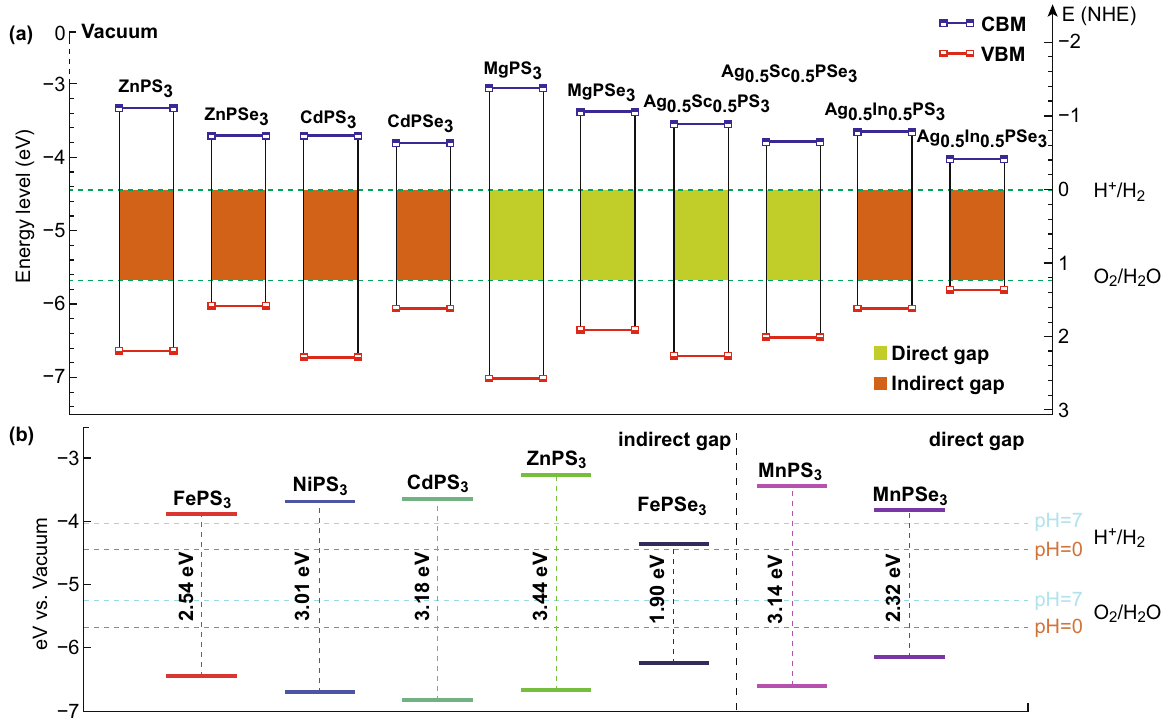
Fig. 2 a Band-edge positions of MPQ 3 single layer. The energy scale is indicated by either the normal hydrogen electrode (NHE) (right Y -axis) or the vacuum level (left Y -axis) in electron volts as a reference. The redox potentials (green dashed line) for water splitting are shown for comparison [49]. Copyright (2001), Macmillan Publishers Ltd. b Location of VBM and CBM, calculated with HSE06 functional, for MPS 3 and MPSe 3 single layers. The redox potentials for water splitting at pH = 0 (orange dashed lines) and pH = 7 (cyan dashed lines) are shown for comparison [55]. Reproduced with permission. Copyright (2016), Wiley–VCH, GmbH & Co. KGaA. (Color figure online)